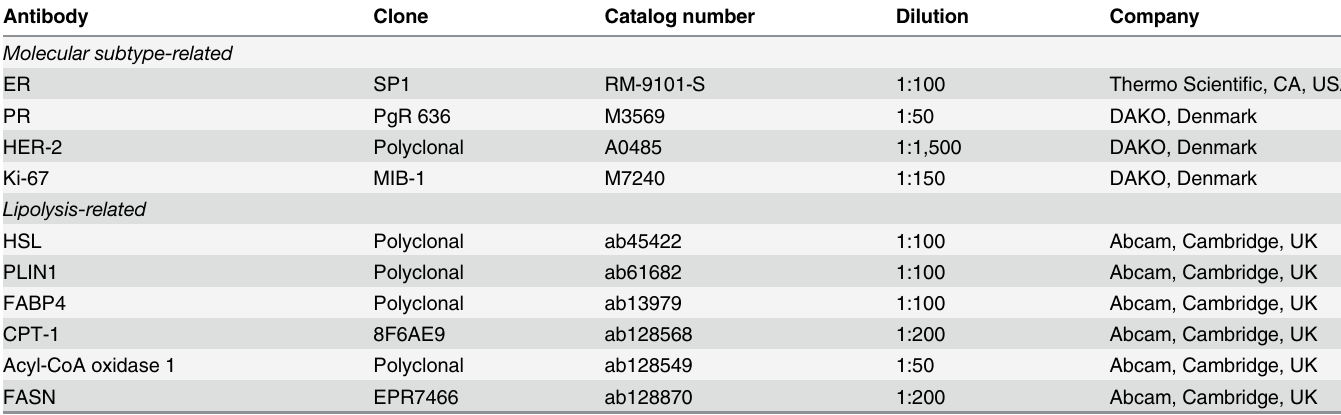
Table 1. Source, clone, and dilution of antibodies used in this study.